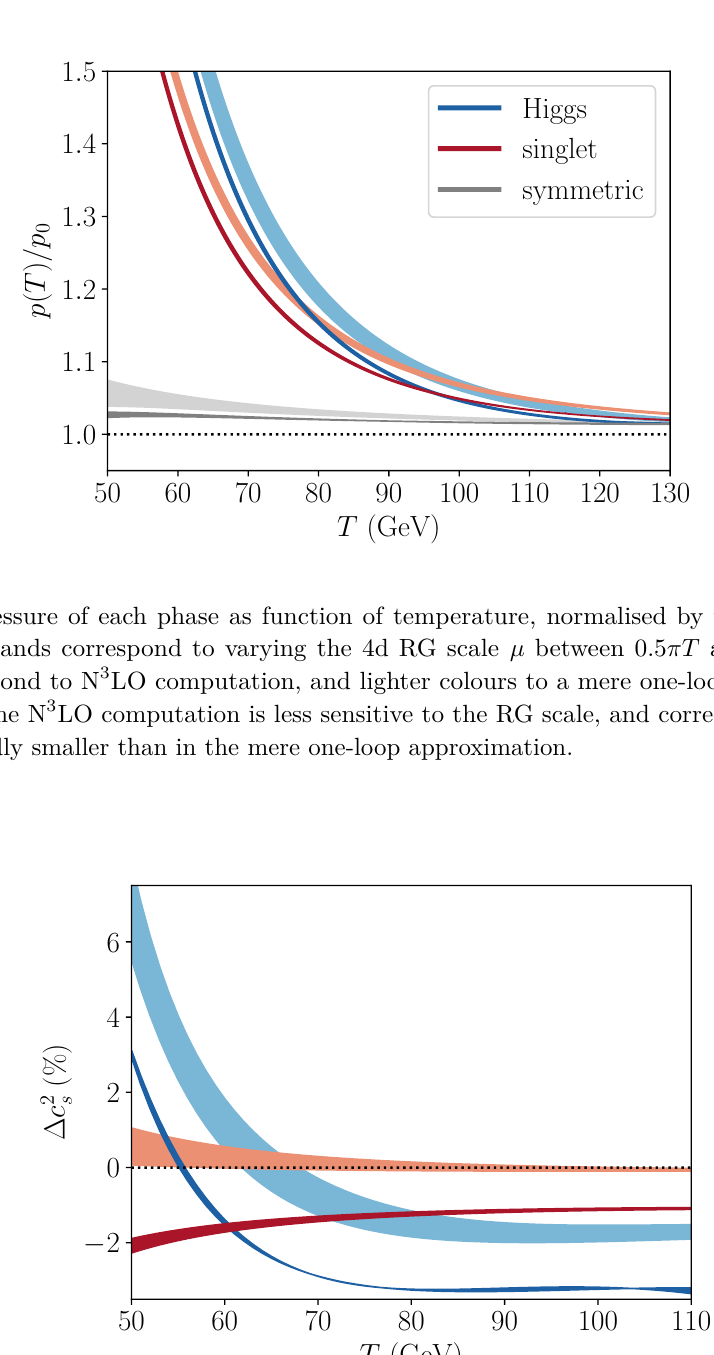
/ 3 in the singlet phase (red) and s = 1